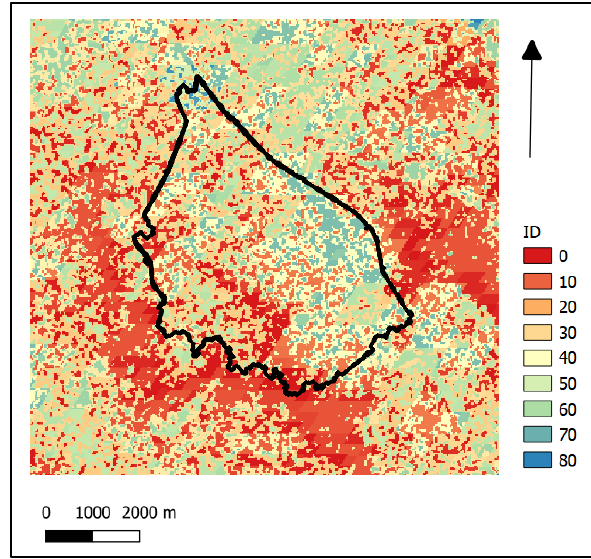
Figure 5.3. Threshold Value =